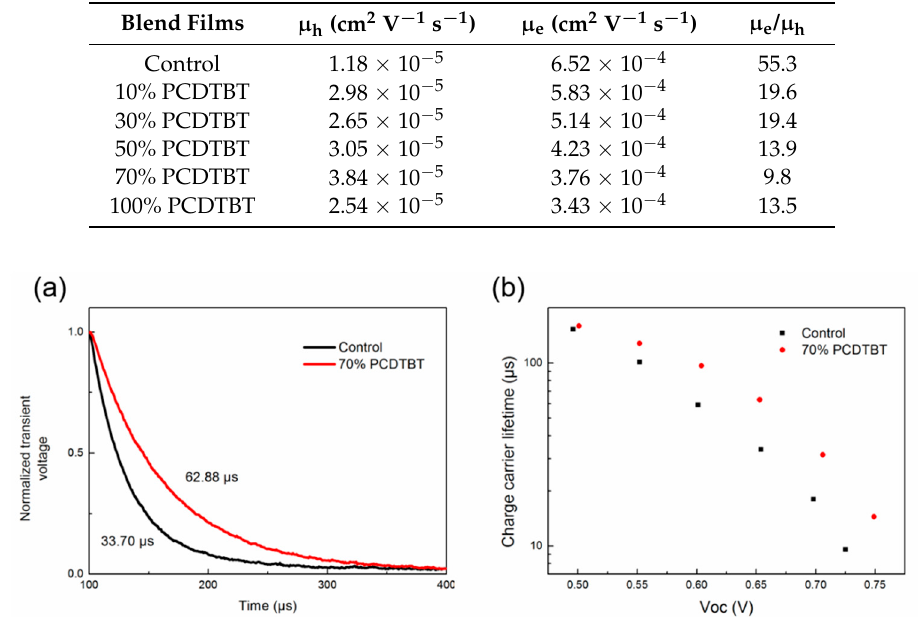
Figure 7. Transient photovoltage (TPV) measurement. ( a ) Δ V OC –time characteristics of binary and ternary devices when the V OC of solar cells was kept at 0.65 V; ( b ) Charge carrier lifetime of binary and ternary devices measured under different V OC conditions.